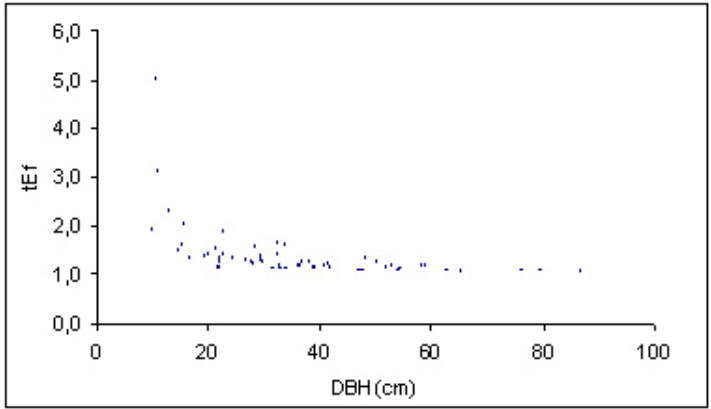
FIGURE 9 . Scattergram of reduction factors as a function of DBH.